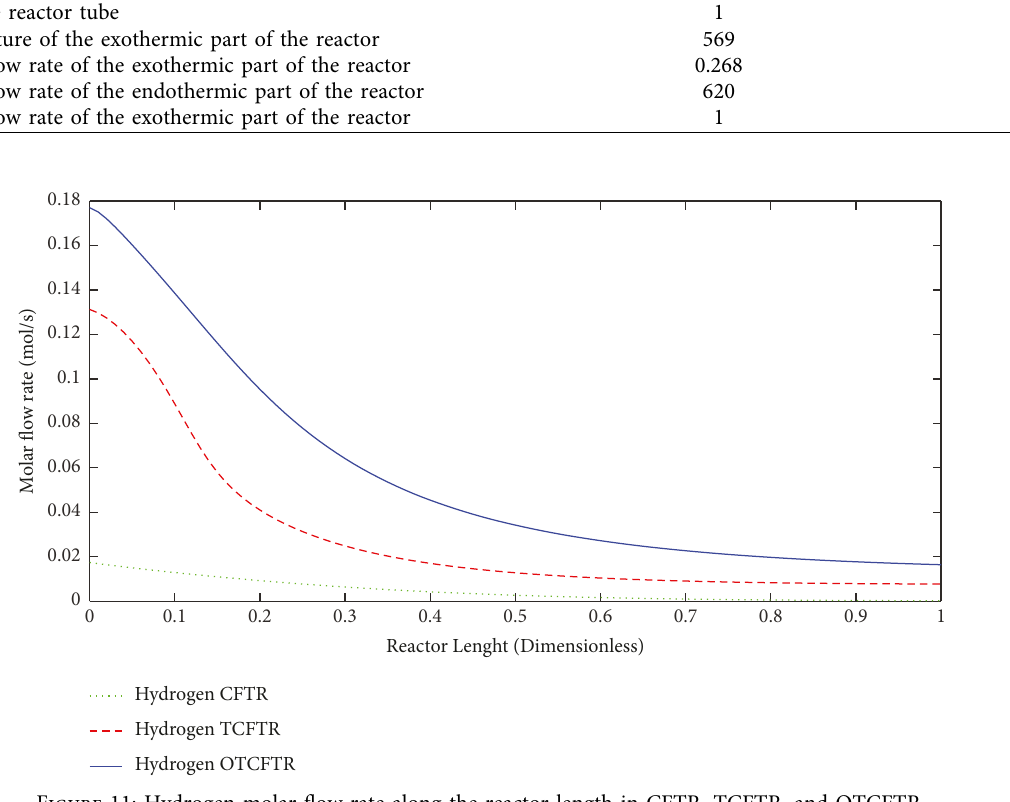
Figure 11: Hydrogen molar flow rate along the reactor length in CFTR, TCFTR, and OTCFTR.